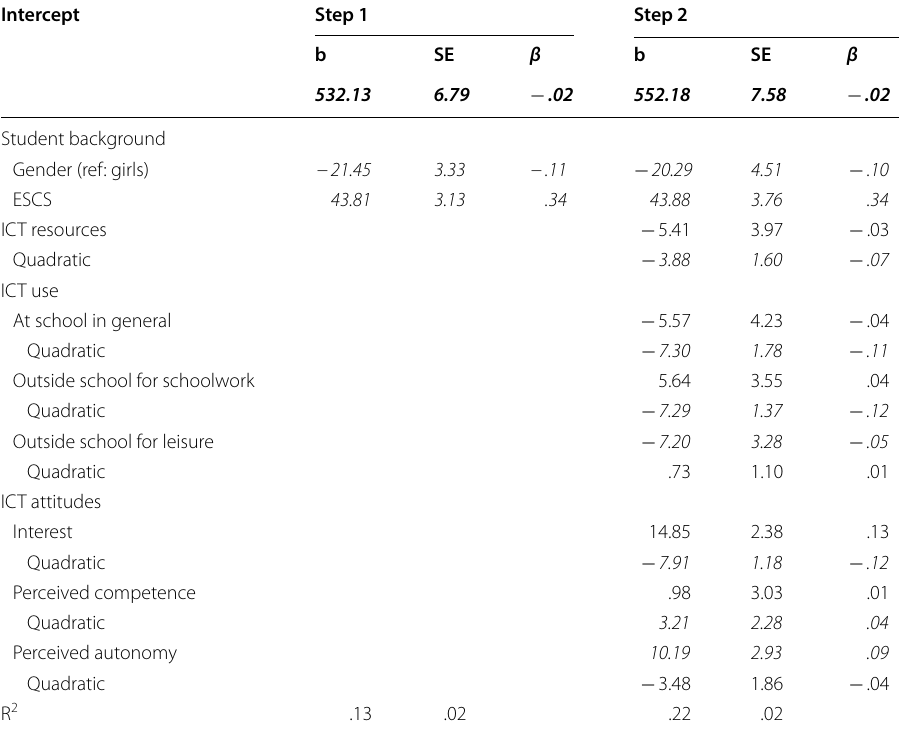
on digitally assessed reading